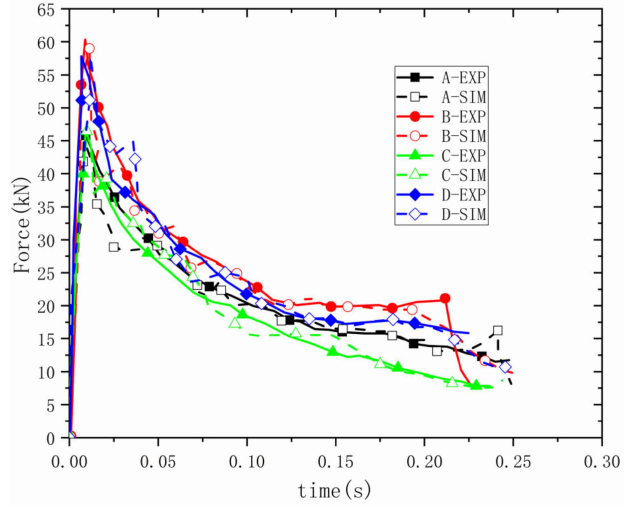
Figure 7. Comparison between test and simulation of five-section tubular C-frame.